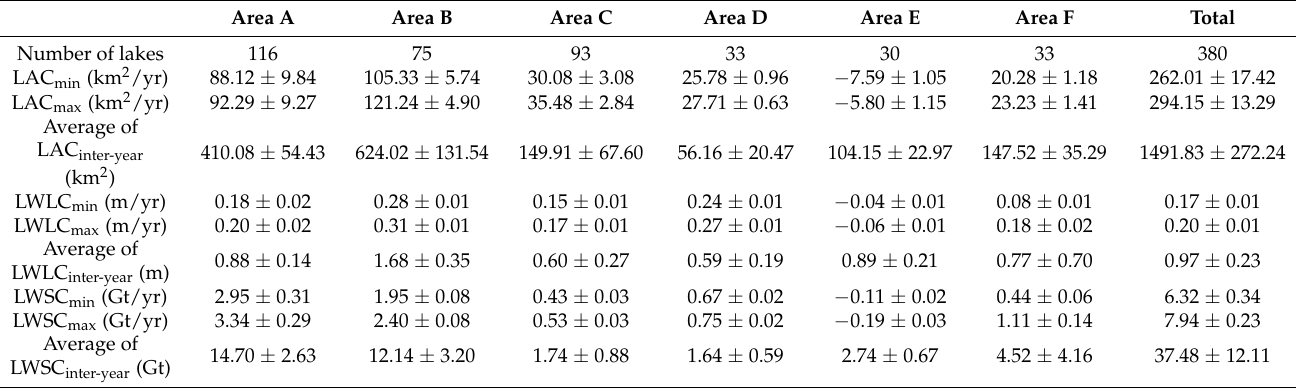
Table 1. Changes in LA, LWLC, and LWSC in different Areas of the TP from 2000 to